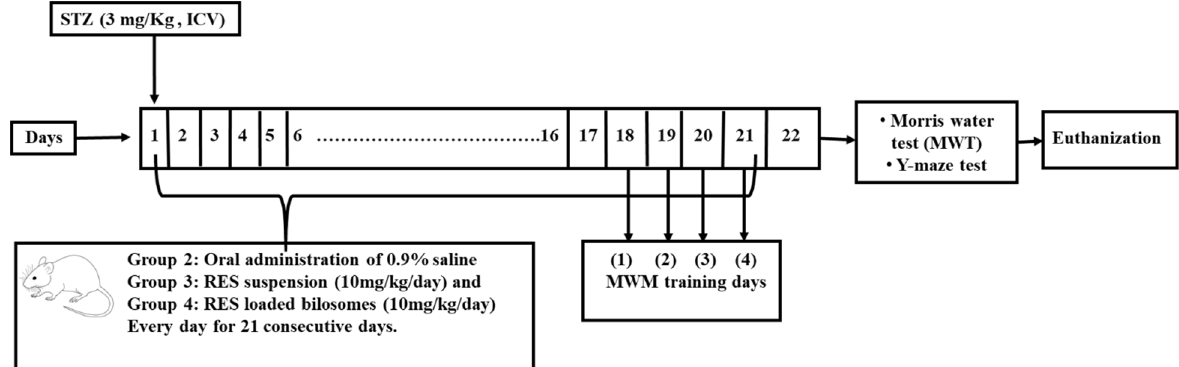
Figure 1. A schematic diagram for the experimental design showing Alzheimer’s disease induction by intra- cerebroventricular injection (ICV) of Streptozocin (STZ) (3 mg/kg) on the first day, followed by oral administration of 0.9% saline, Resveratrol (RES) suspension (10 mg/kg/day) and RES-loaded bilosomes (10 mg/kg/day) for Groups 2, 3 and 4 respectively for 21 days. Each group contained eight mice. All behavioral, biochemical, histological and immuno-histochemical assessments were conducted on day 21.